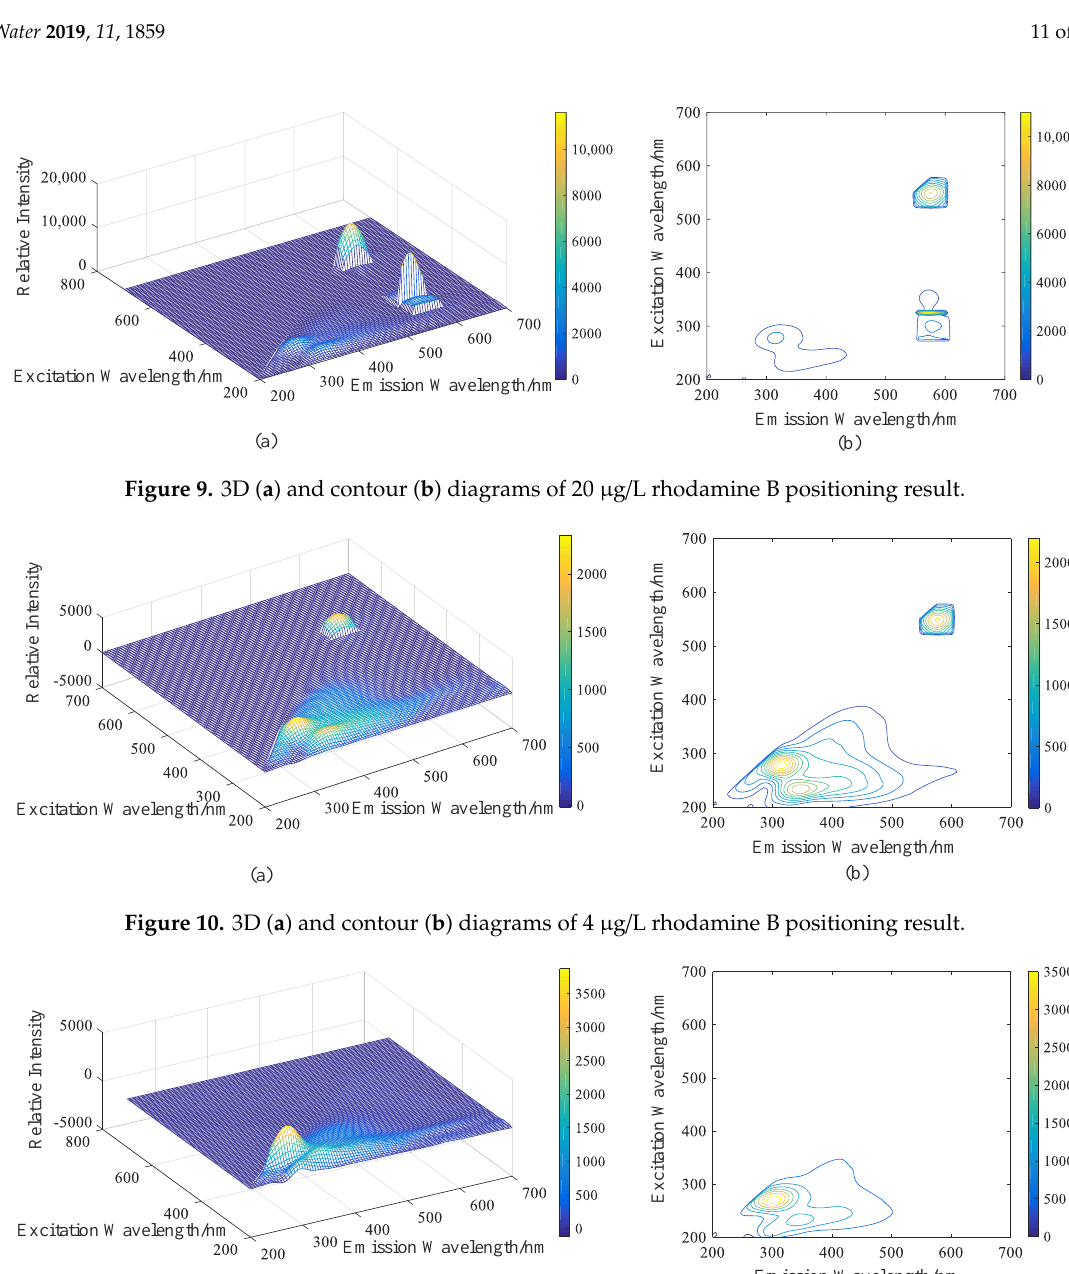
Figure 8. 3D ( a ) and contour ( b ) diagrams of 4 μg/L salicylic acid positioning result.